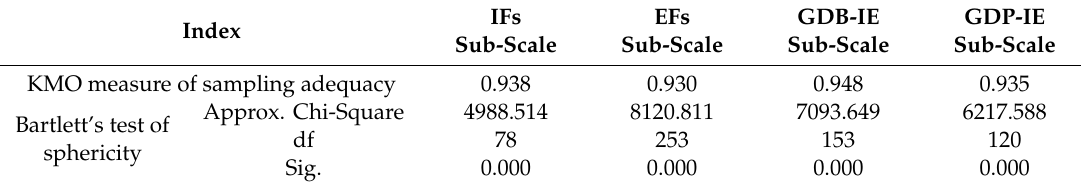
IFs EFs GDB-IE GDP-IE Sub-Scale Sub-Scale Sub-Scale Sub-Scale